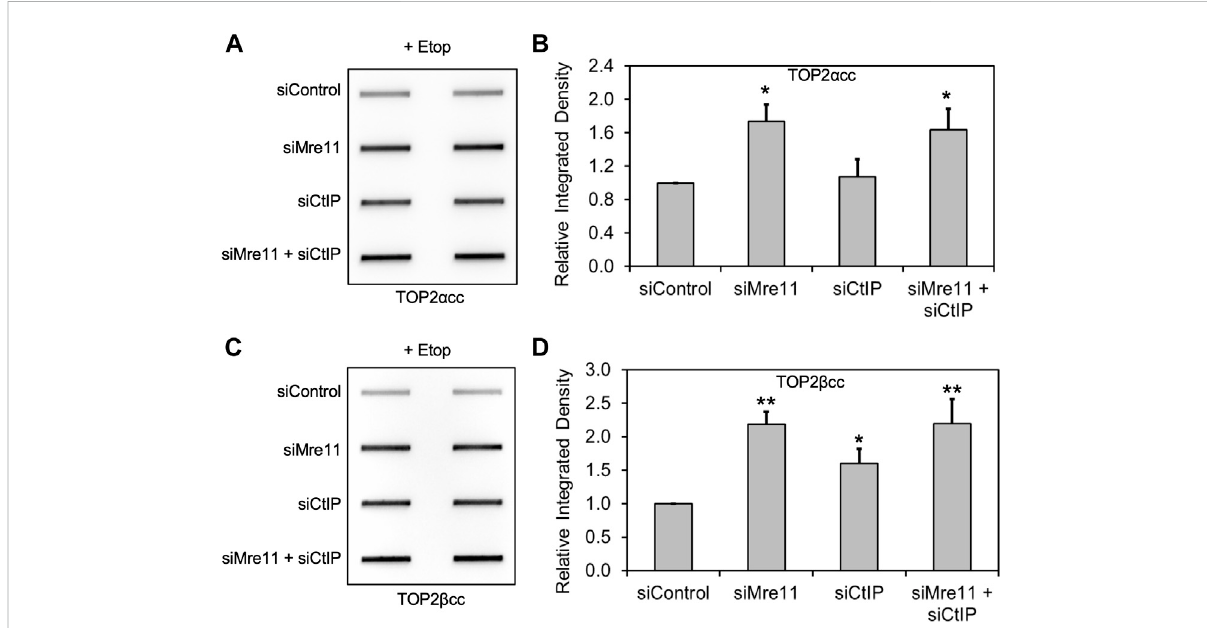
FIGURE 3 KnockdownofMRE11andCtIPareepistaticforrepairofTOP2covalentcomplexes.WecarriedoutsiRNAknockdownsasinFigure1(forMRE11) and Supplementary Figure S1 (for CtIP). The results shown were following treatment with 10 μ M etoposide for 2 h. (A) ICEassay illustrating TOP2 α cc under the conditions indicated. (B) Densitometric analysis of all experiments comparing relative integrated densities of TOP2 α cc signal. Integrated density of TOP2 α cc signal of each group was normalized to that of cells treated with siControl. (C) ICE assay illustrating TOP2 β cc under the conditions indicated. (D) Densitometric analysis of all experiments comparing relative integrated densities of TOP2 β cc